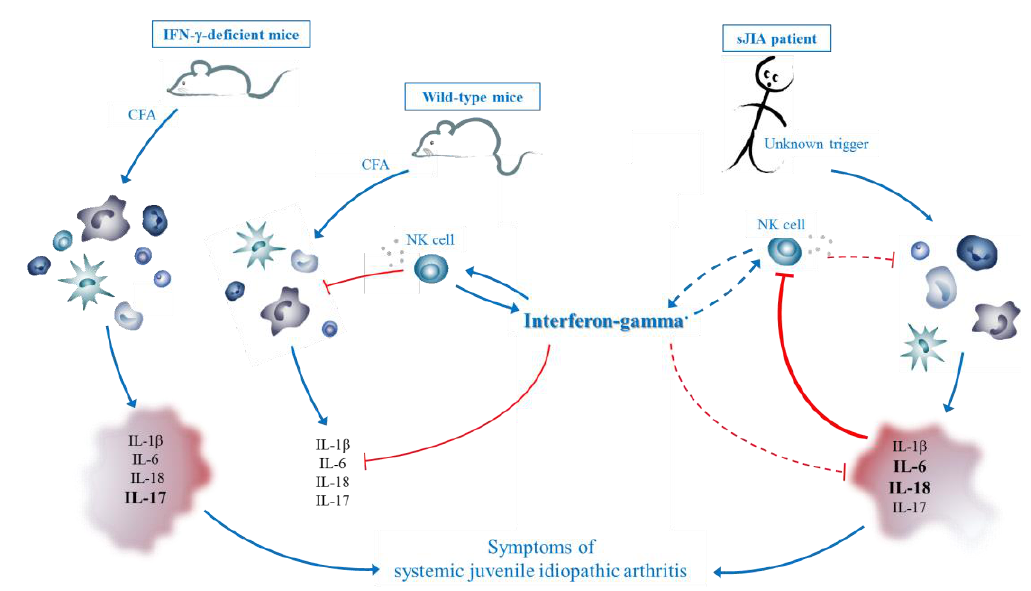
Figure 2. Proposed disease mechanism in mice and patients, with a central protective role of IFN-γ. ( Left ) In mice, complete Freund’s adjuvant (CFA) injection results in a local and systemic inflammatory reaction, leading to the expression of proinflammatory cytokines by activated immune cells. In wild-type mice ( middle ), IFN-γ counteracts the production of these cytokines by inhibiting IL-17-producing cells and by inducing NK cell cytotoxicity. Triggered NK cells kill activated immune cells by the release of cytotoxic granules. In the absence of IFN-γ (IFN-γ-deficient mice, left ), NK cell function is defective, and activated immune cells keep producing proinflammatory cytokines. IFN-γ-associated inhibition of IL-17 is absent. As a consequence, the immune response is not ended properly, eventually resulting in typical sJIA-like symptoms; ( right ) In patients, an unknown trigger and